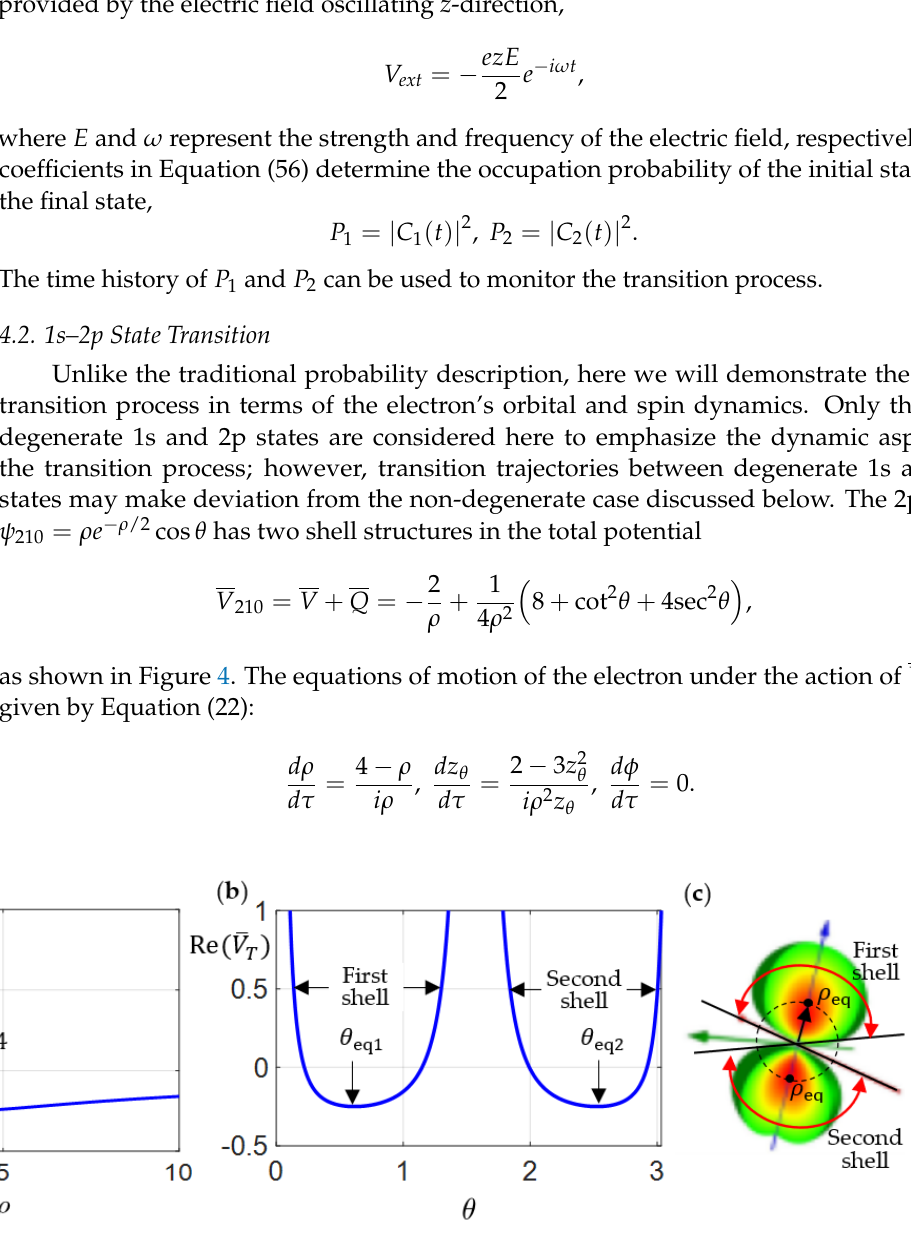
Figure 4. The variation of the real-part total potential of the 2p state: ( a ) in the radial direction with equilibrium position at 𝜌 eq = 4 ; ( b ) in the 𝜃 direction with equilibrium positions at 𝜃 eq = cos −1 (±√2 3⁄ ) . ( c ) The probability distribution (electron cloud) of the 2p state has two shells along the 𝜃 direction and the brightest point is located at 𝜌 eq along the radial direction.